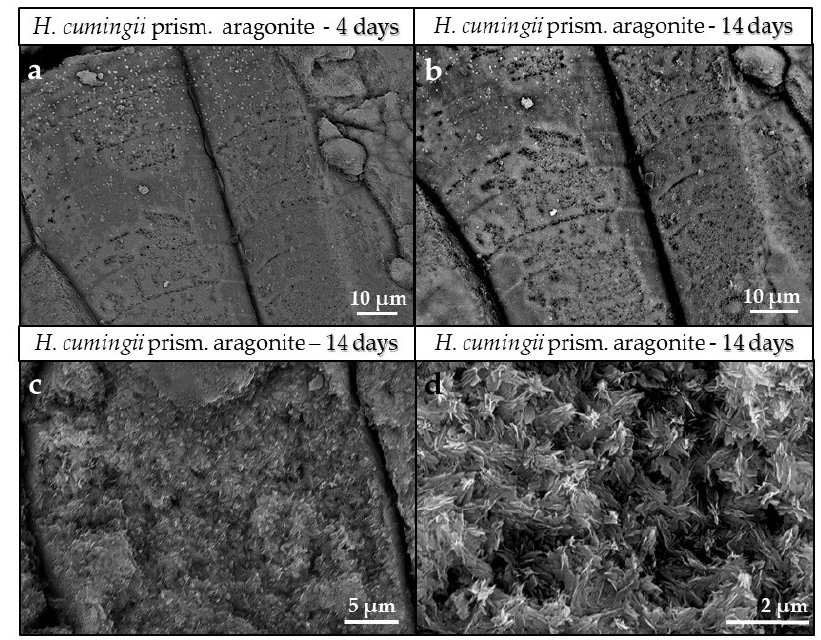
Figure 6. FE-SEM images showing Hyriopsis cumingii aragonite prisms altered for ( a ) 4 and ( b – d ) 14 days. Overall prism morphology does not change with alteration time. A layer of newly formed AP crystals covers the surface of the prisms already at 4 days of conversion. It increases in denseness with conversion time. Crystal morphologies in ( d ) clearly show that the aragonite within the prisms becomes converted to apatite at 14 days of alteration.